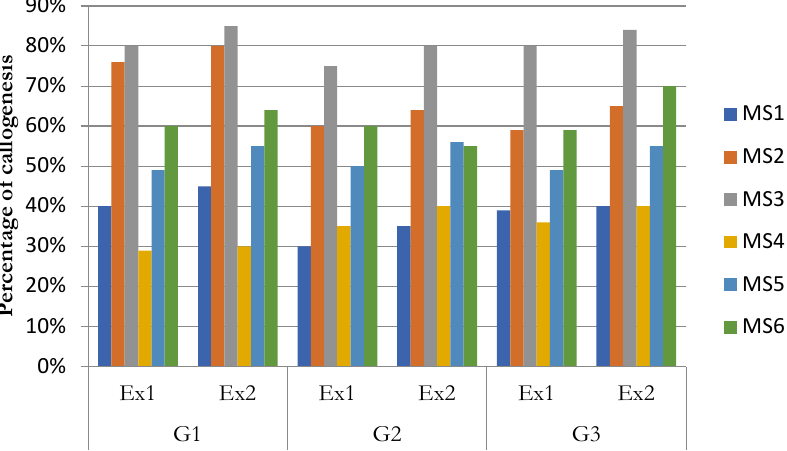
Figure 2. Effect of hormone balance, genotype, and explant type on the callogenesis of Cicer arietinum G1: FLIP 84-92C, G2: ILC 32-97, G3: ILC 263 Ex 1: leaflet explants, Ex 2: stem